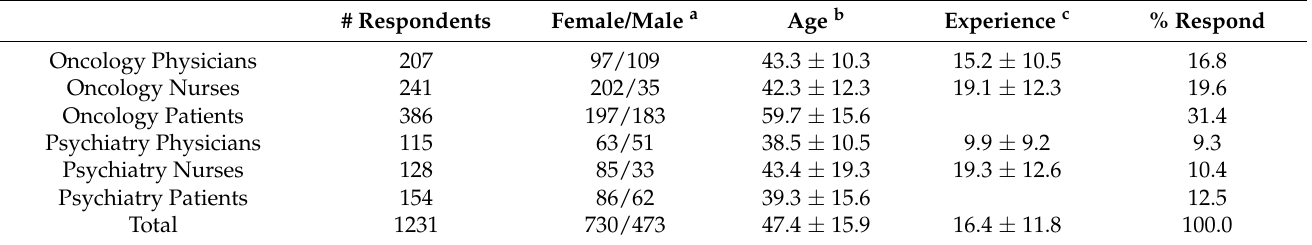
Table 1. Numbers of respondents within the stakeholder groups.